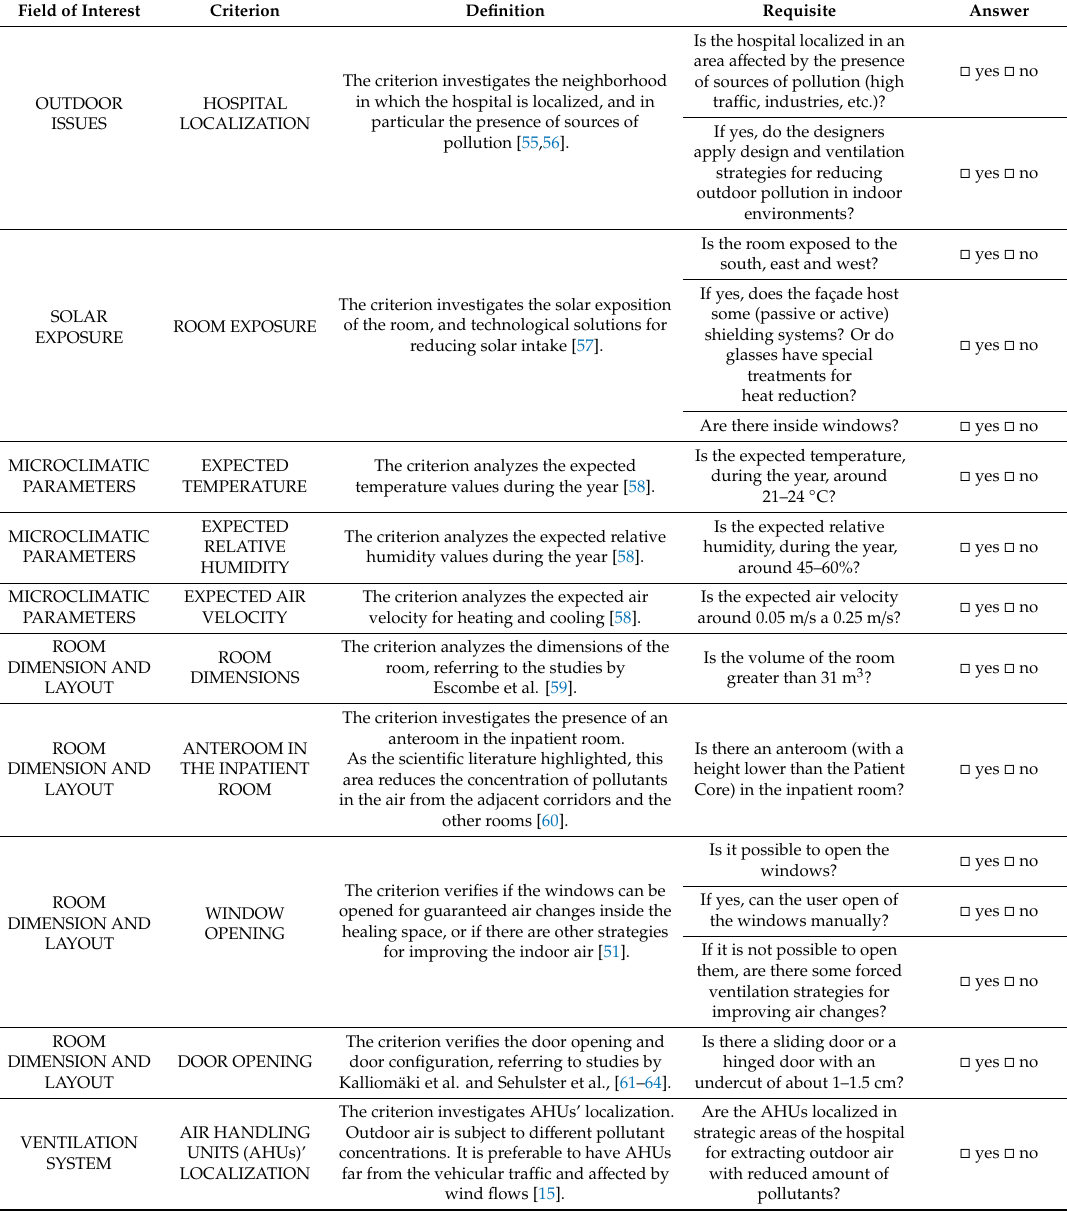
Table 1. Check-list for the design